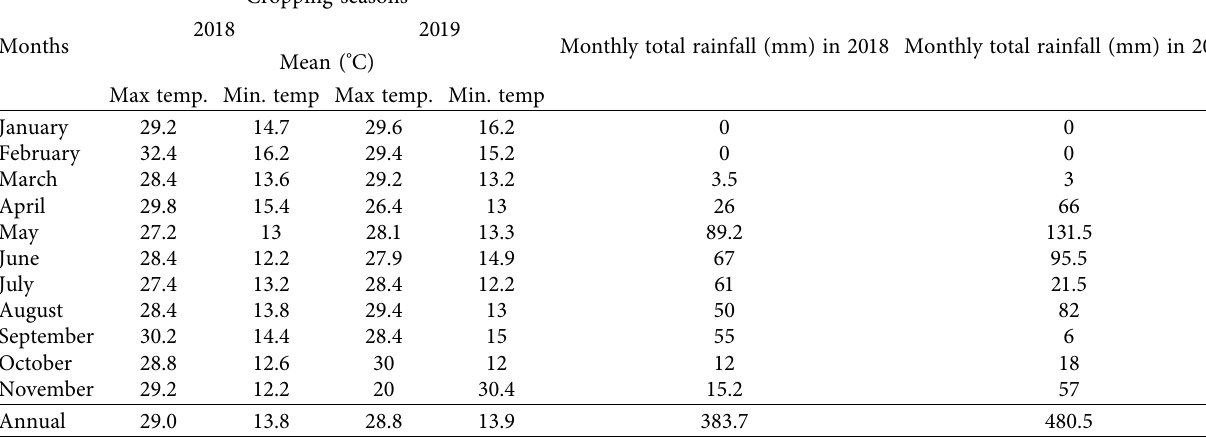
Table 1: Monthly maximum and minimum temperatures ( ° C) and monthly total rainfall (mm) at Babile during the 2018 and 2019 cropping seasons (Babile meteorological station).